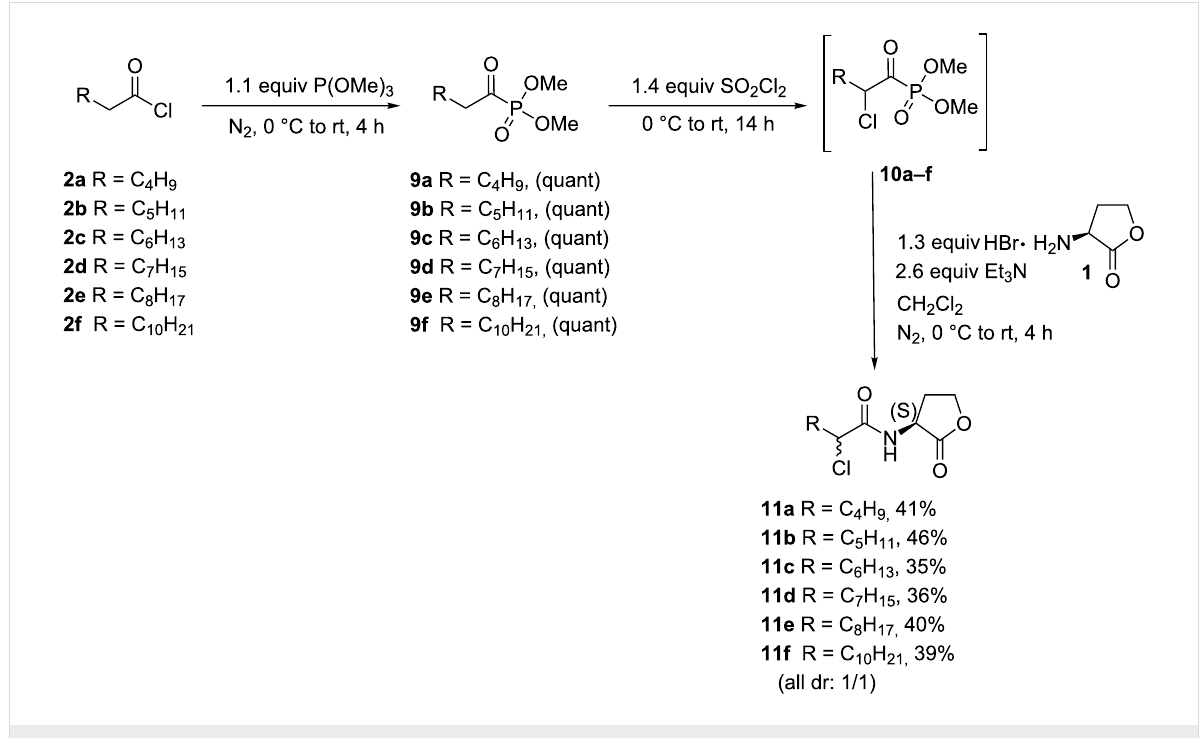
Scheme 3: Synthesis of chlorinated AHL analogues 11a – f